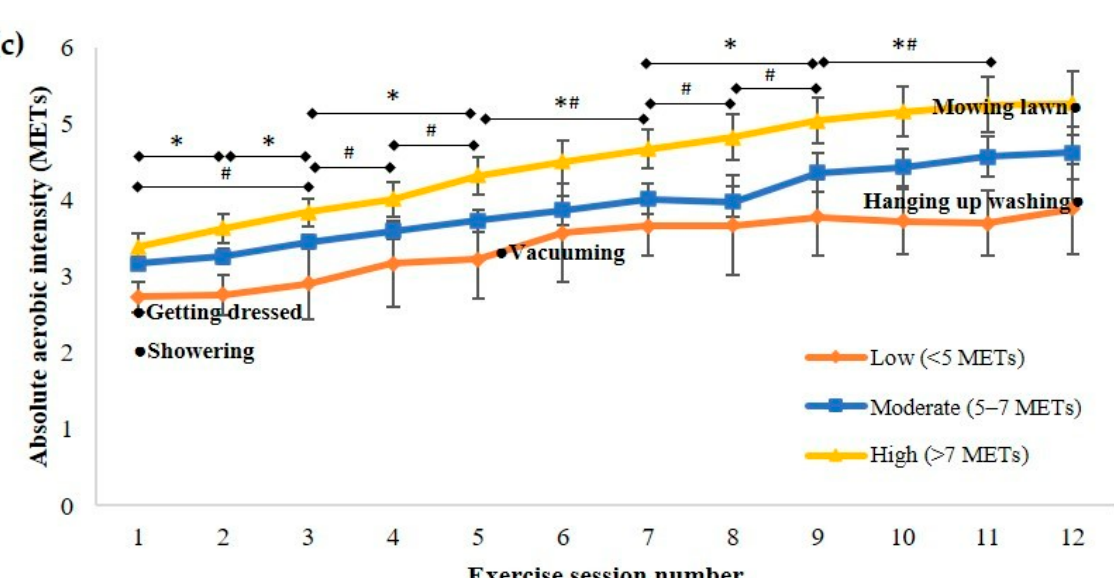
Figure 2. Comparison of the absolute aerobic intensity in metabolic equivalents (METs) prescribed during cardiac rehabilitation sessions with the requirements of activities of daily living, for patients categorised by ( a ) age; ( b ) cardiovascular intervention; and ( c ) initial physical capacity. Data presented as mean (95% CI). * Significant progression in absolute aerobic intensity for ( a ) <65 years; ( b ) non-surgical intervention; and ( c ) high physical capacity. # Significant progression in absolute aerobic intensity for ( a ) ≥ 65 years; ( b ) surgical intervention; and ( c ) moderate physical capacity. The mean (95% CI) absolute walking intensity increased from the first session (3.1